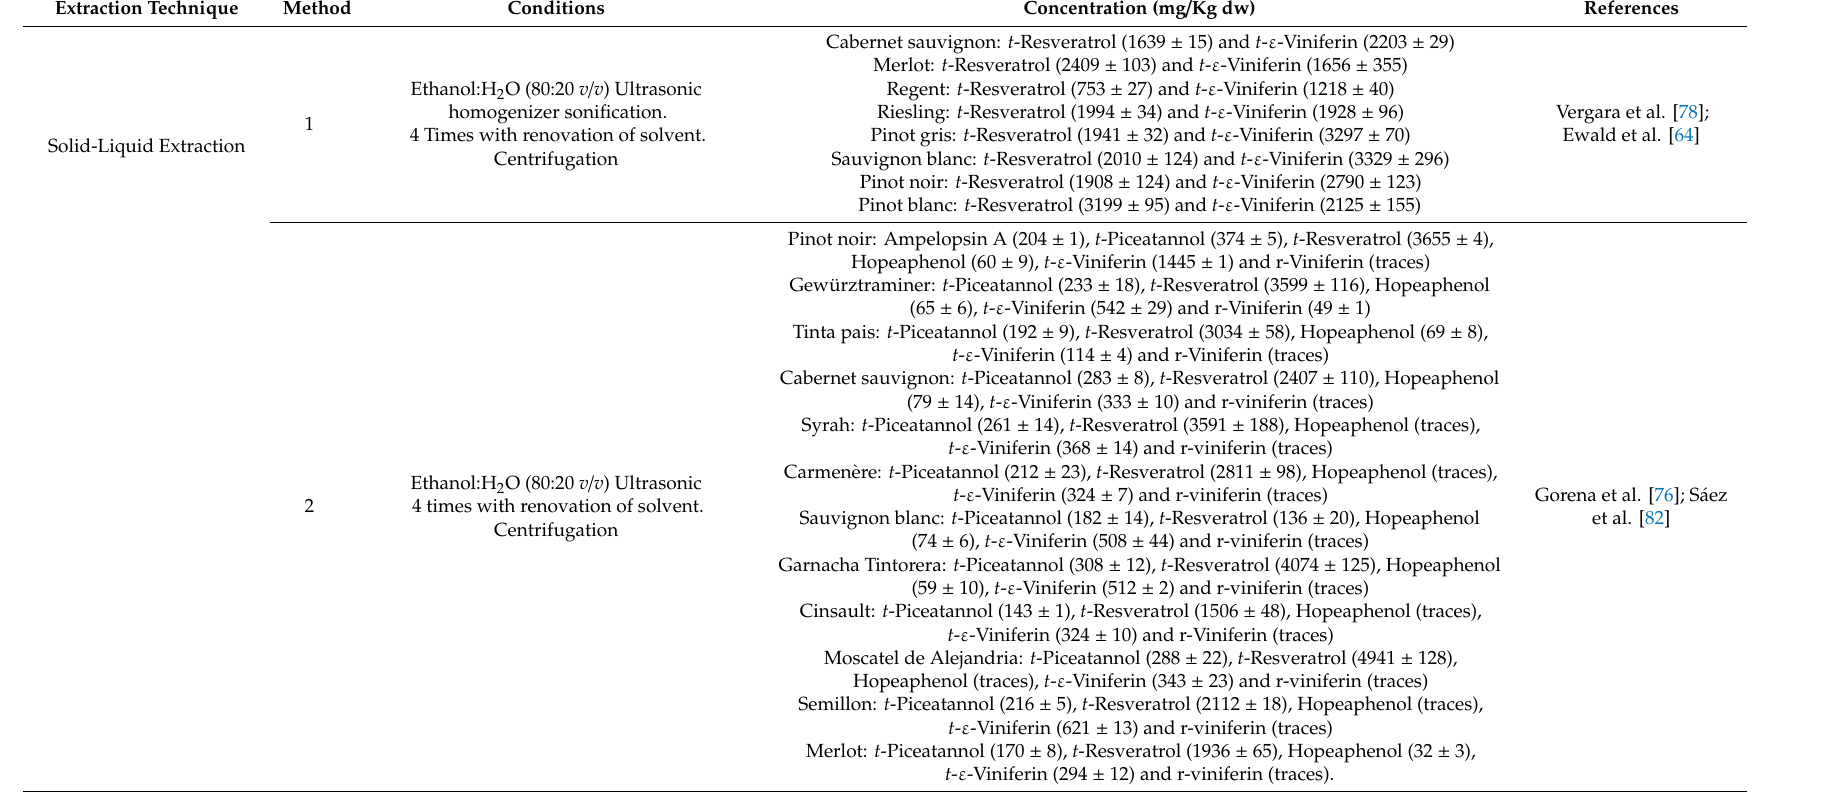
Table 2. Summary of conditions of the methods for extracting stilbenes from grapevine